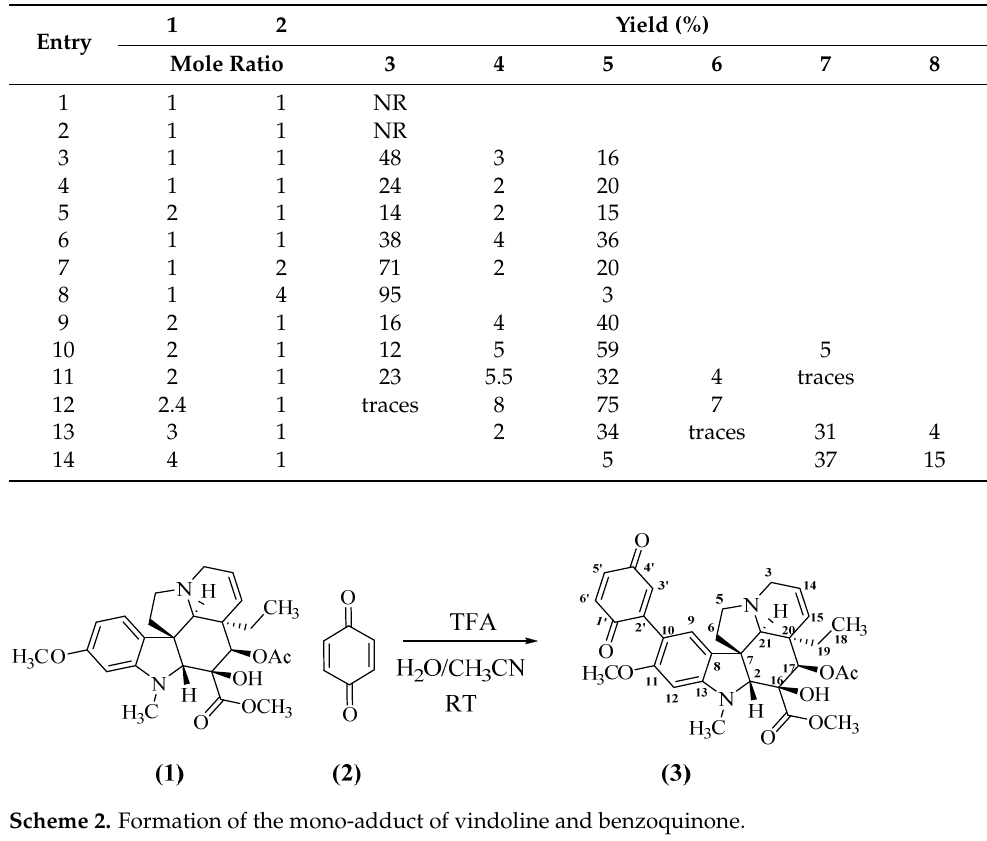
Table 1. Products obtained with vindoline 1 addition to benzoquinone 2 . Reaction conditions: all